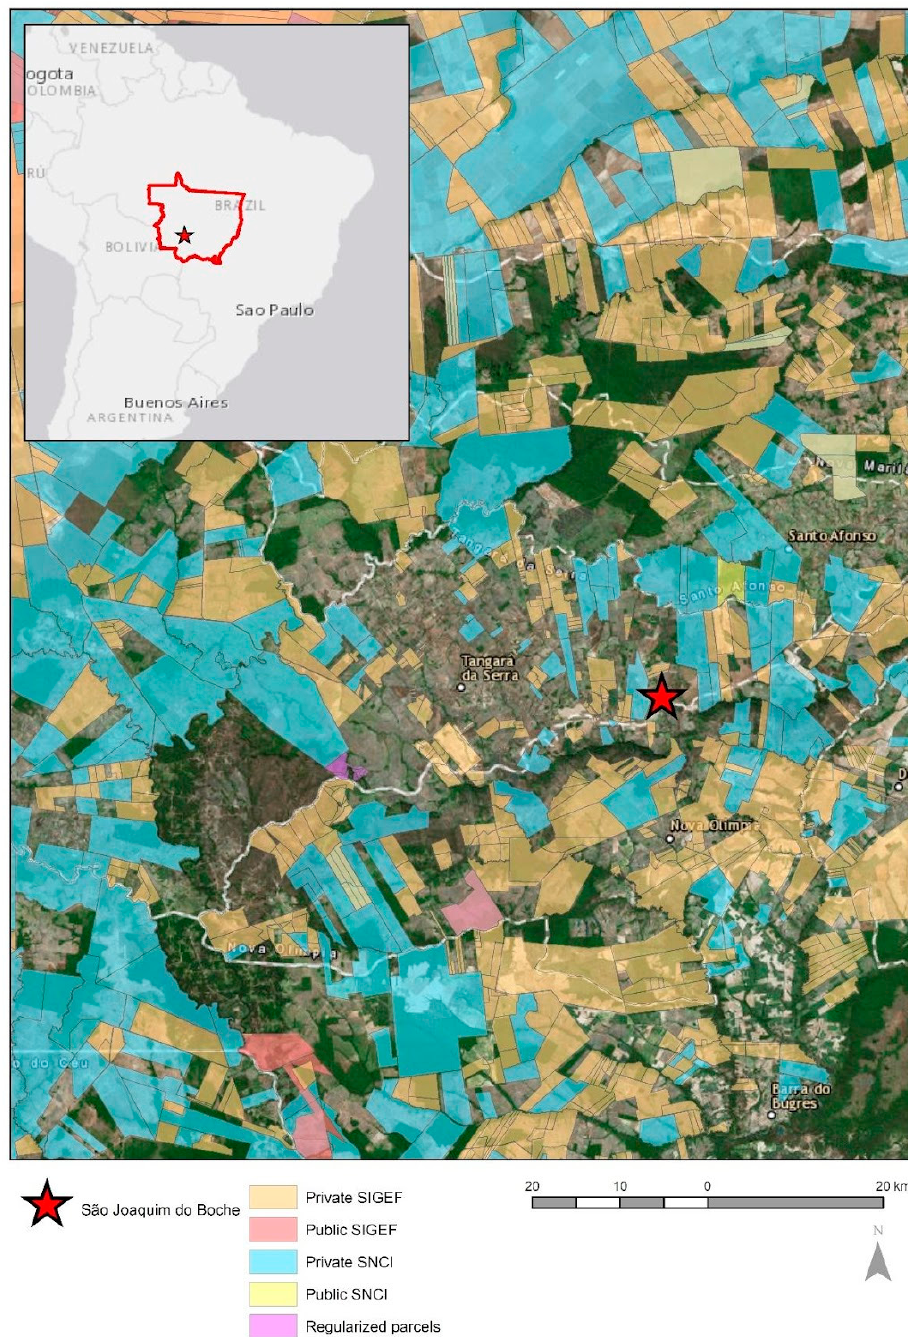
Figure 5. Land tenure mosaic of the Tangará da Serra region and intervention case location. Tangará da Serra provides us with a unique opportunity of work in Mato Grosso and in Brazil due to its pioneer initiative of mapping all known properties that are already registered and by other secondary information from Brazil’s official cadaster system that are within the municipality. Therefore, we were able to identify an unregistered commu- nity that could be formalized by the fit-for-purpose methodology. Then, the community of “São Joaquim do Boche”, in the rural area of the municipality was chosen to be part of